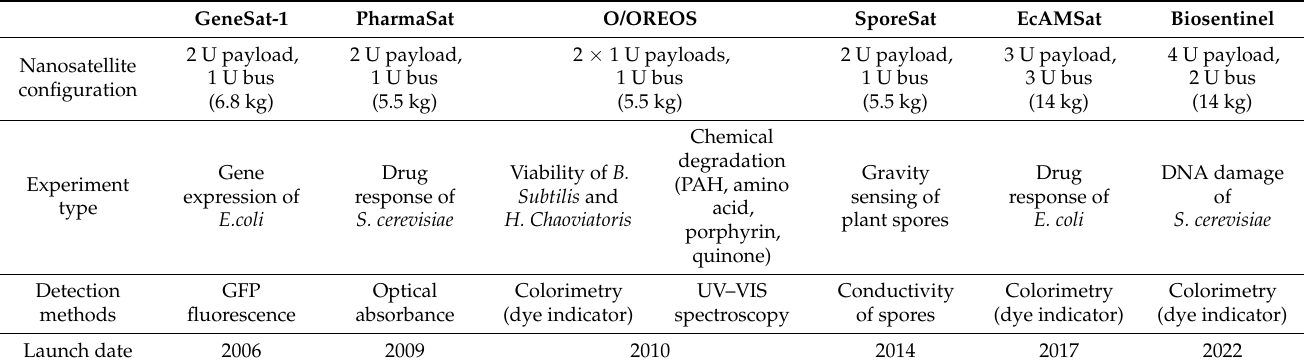
Table 1. CubeSat type biological